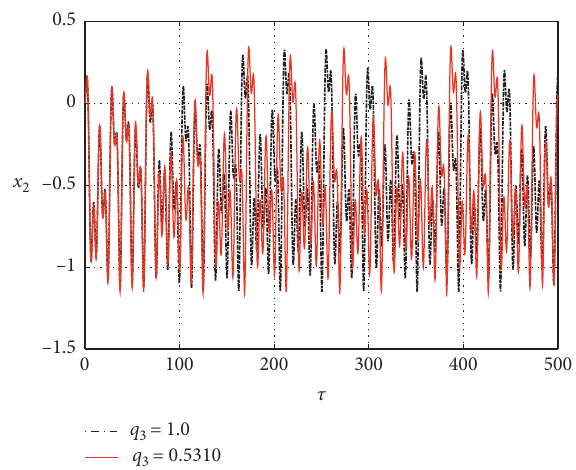
Figure 15: Time series of fractional order of the system with q 3 � 1.0 and q 3 � 0.5031.